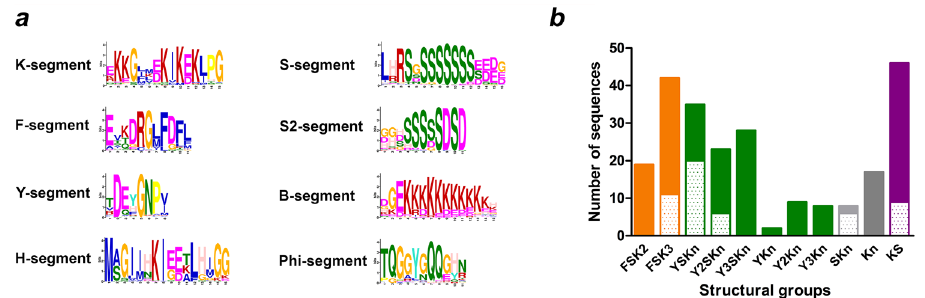
Figure 2. Identification of conserved protein motifs and structural classification of DHNs. ( a ) LOGO representation of the different conserved motifs detected by MEME in the set of DHNs of the unbiased database. ( b ) Number of members of each angiosperm DHN structural subgroup identified in the unbiased database. We distinguished FSK2 and FSK3 structural subgroups in accordance to Strimbeck 6 . All classified DHNs belonging to 19 angiosperm families are listed in Supplementary Data S1. The dotted pattern indicates monocots, while the filled pattern indicates eudicots.